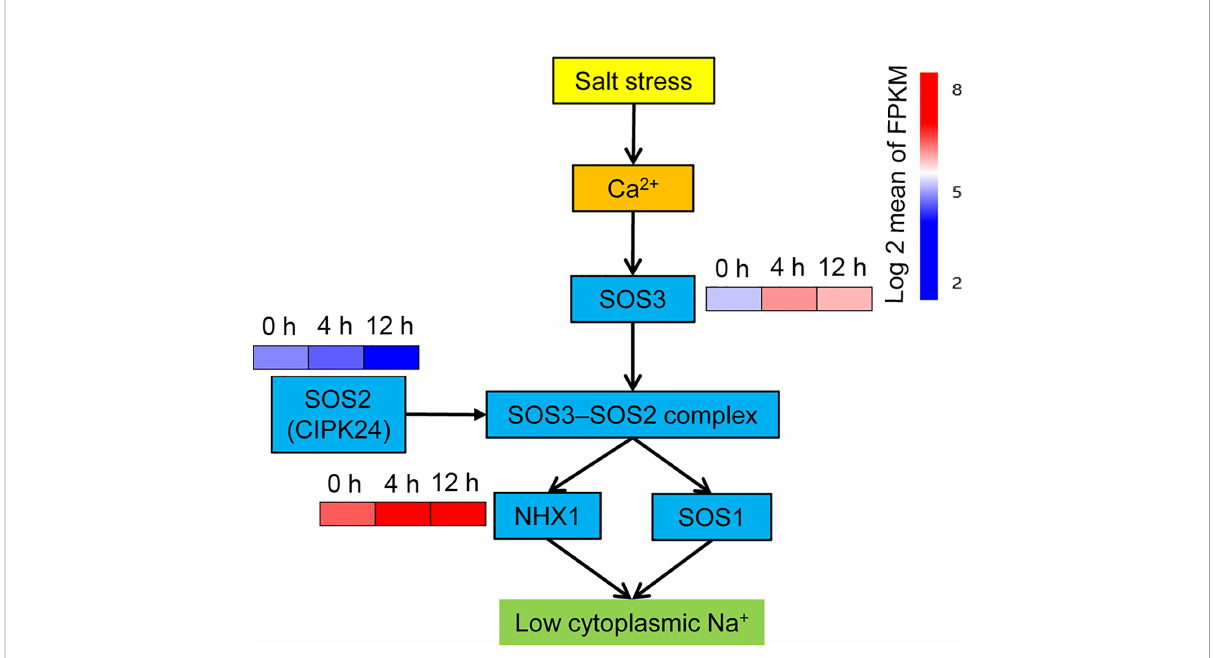
FIGURE 5 Expression analysis of SOS pathway genes. SOS, salt overly sensitive. The pathways were redrawn according to Tuteja (2007). Genes that changed signi fi cantly in at least one time point after salt treatment are